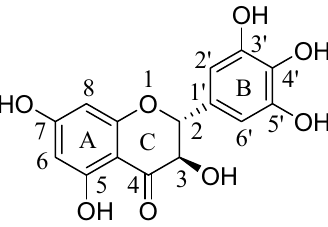
Figure 1. The structural of DMY (Version number: ChemOffice Professional 19, URL link: https ://www.chemd raw.com.cn/produ